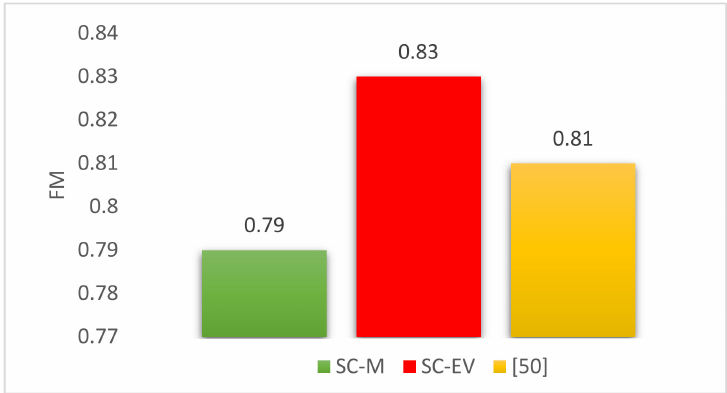
Figure 13. f-measure comparison of proposed and benchmark study